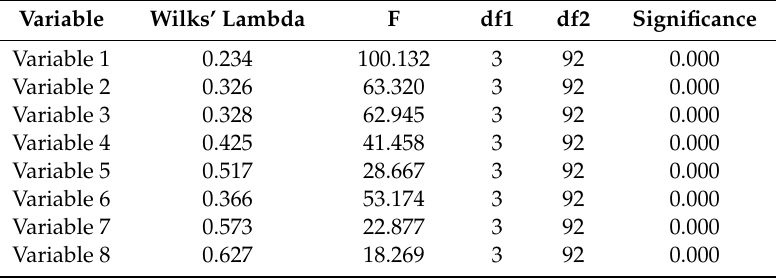
Table 14. Wilks’ Lambda.